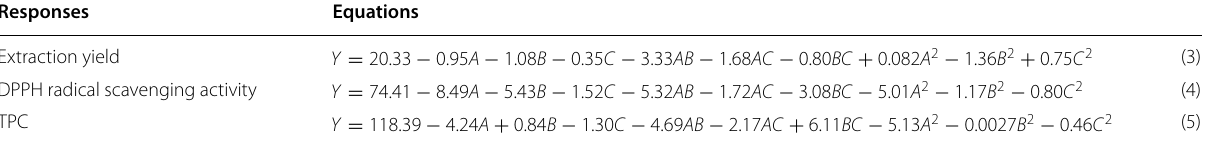
In these equations, Y is the predicted response, A , B and C are the values of the independent variables, extraction temperature (°C), extraction time (min) and solvent ratio (water: ethanol) (v/v%), respectively